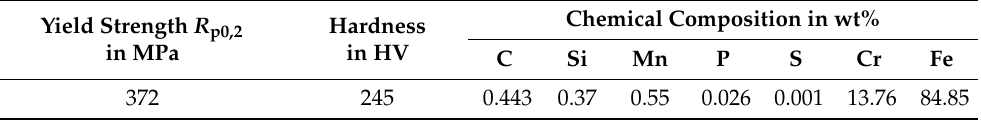
Table 2. Delivery condition of the X46Cr13 coil material according to mill certificate in conformity with EN